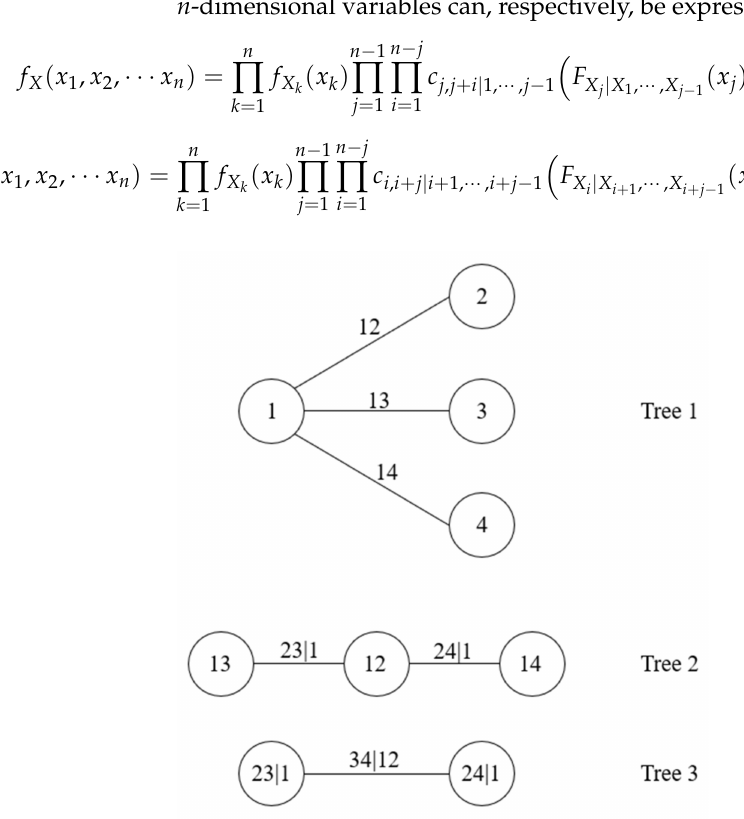
Figure 1. C-Vine model of four-dimensional